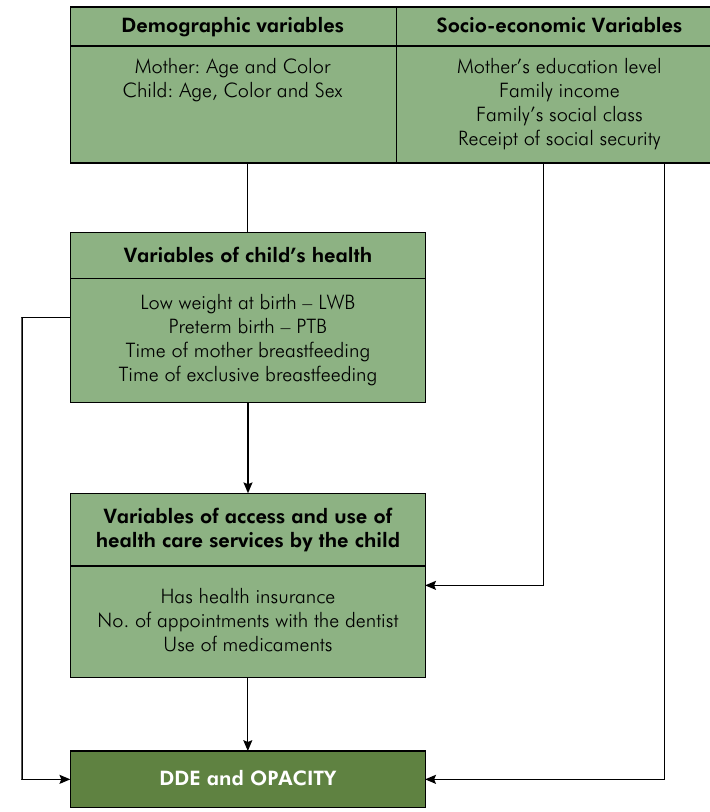
Figure 1. Theoretical model explaining the factors associated with DDE of extra-uterine